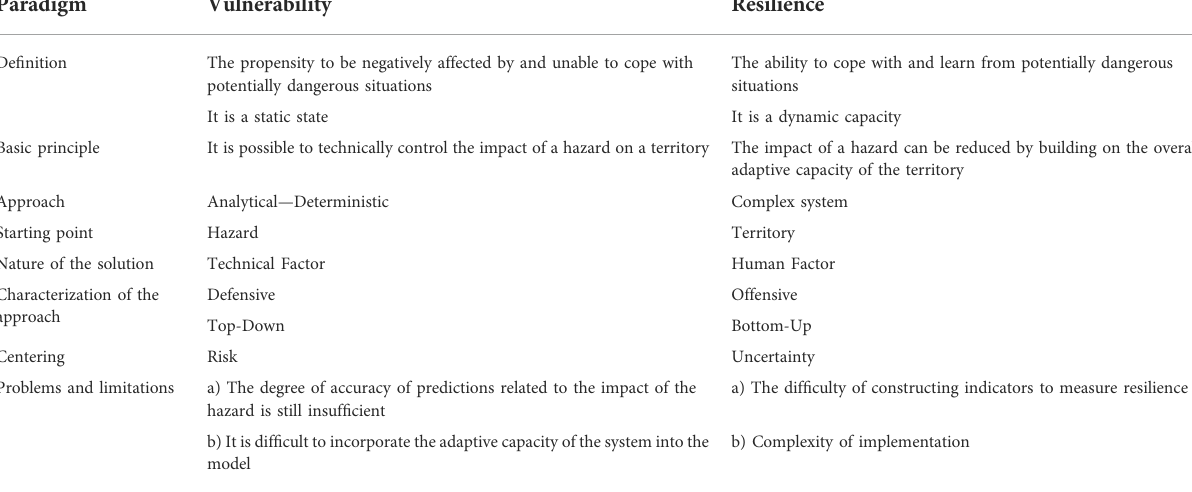
TABLE 1 The contrasts between the paradigms of vulnerability and